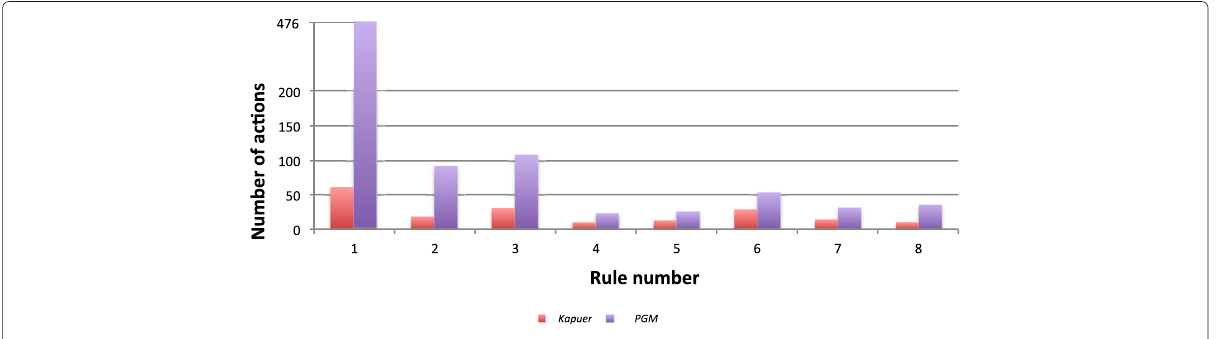
Fig. 14 Comparison of Privacy Guard Manager and Kapuer